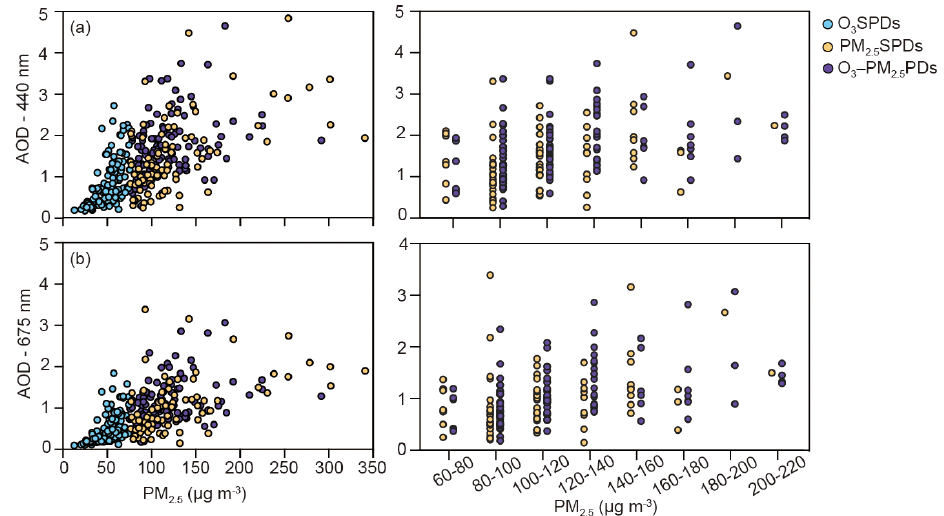
Figure 10. The scatterplots of (a) AOD (440nm) and (b) AOD (675nm) versus observed PM 2 . 5 concentrations on O 3 SPDs, PM 2 . 5 SPDs, and O 3 –PM 2 . 5 PDs in Beijing (39.97 ◦ N, 116.38 ◦ E) in April–October of 2013–2020.